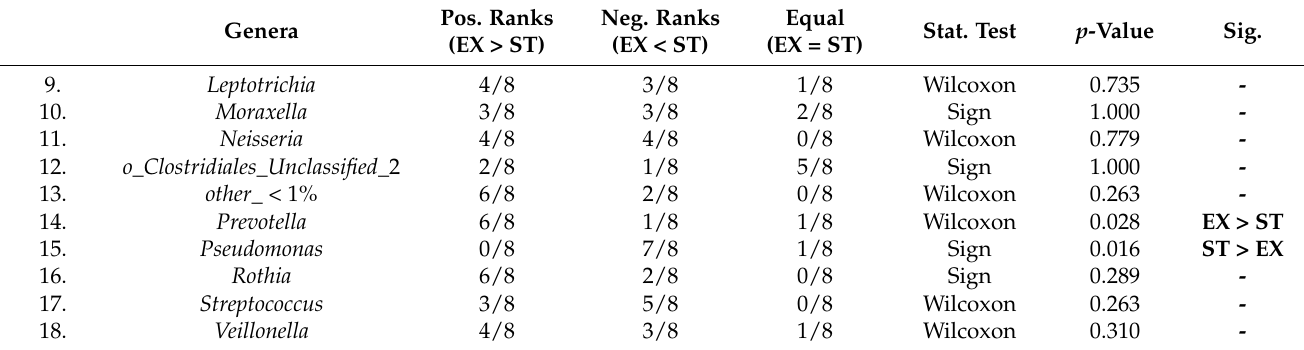
are shown at the lowest known taxon. ST: stable; EX: exacerbation.